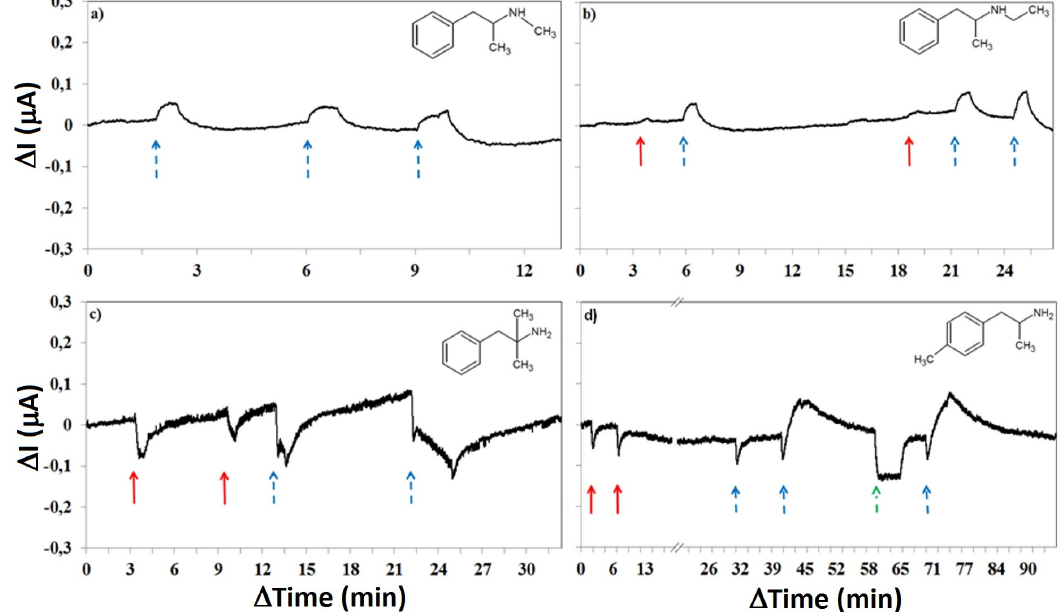
Figure 9. Electrical measurements over time at a bias of 50 mV when different solutions containing amphetamine derivatives were pumped through the system (structural formulas inset). All responses are normalized and baseline-corrected. ( a ) Methamphetamine; ( b ) N -ethylamphetamine; ( c ) Phentermine; ( d ) p -methylamphetamine. The arrows correspond to the color temperature setting of the microscope lamp; green (dash and dot) = fluorescent ceiling light, red (fully drawn) = 2600 K and blue (dash) = 3000